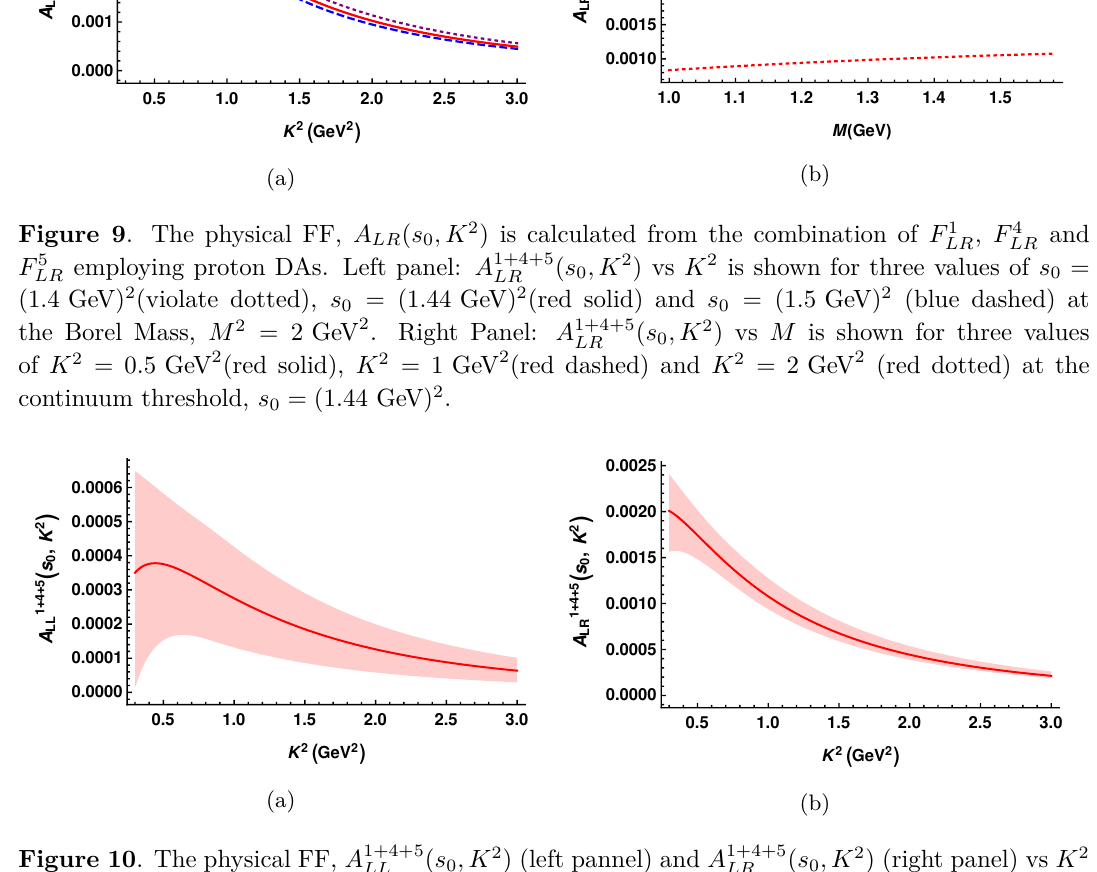
( s 2 ) (right panel) vs K 2 0 , K LR